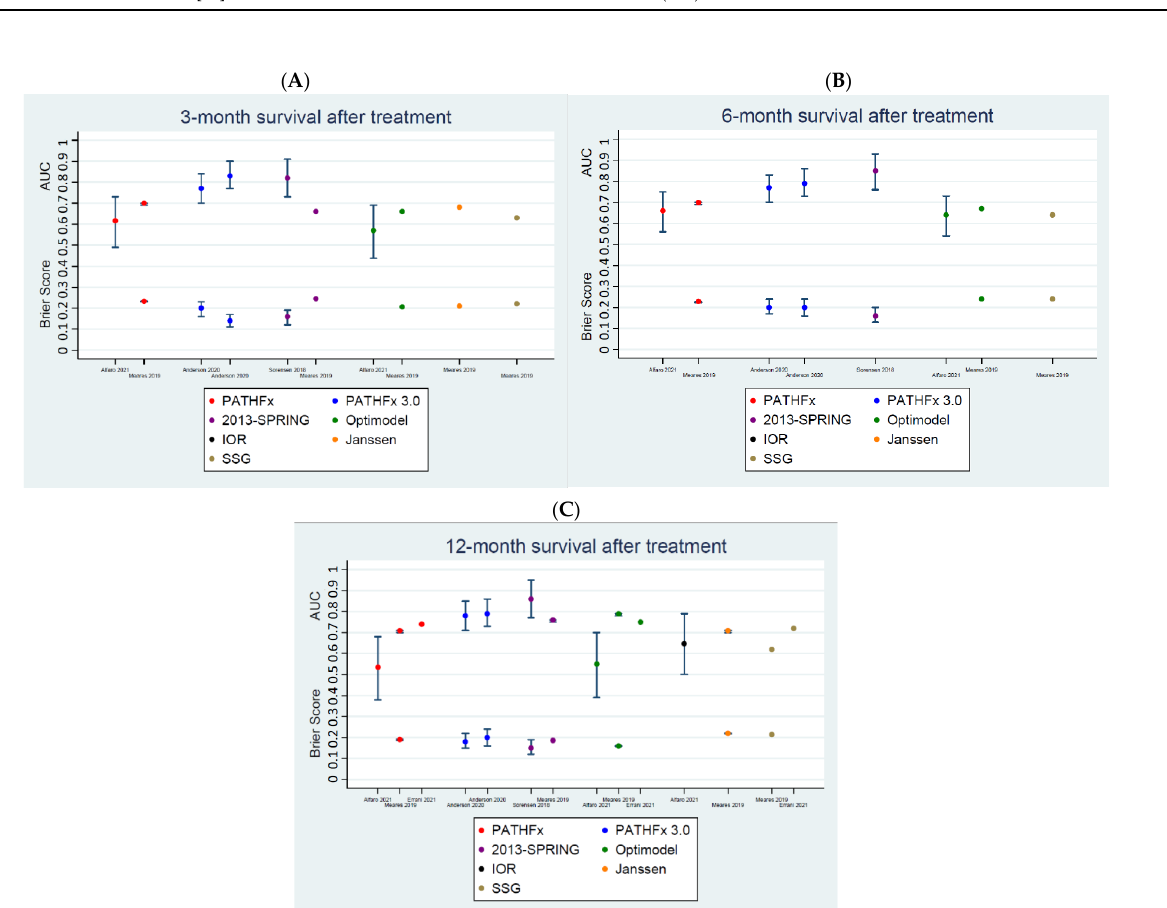
Figure 2. Performance status graphs, AUCs (area under the curve) and Brier scores. ( A ). Comparing metastatic bone disease predicting survival models for 3 months of survival across externally validated studies. ( B ). Comparing metastatic bone disease predicting survival models for 6 months of survival across externally validated studies. ( C ). Comparing metastatic bone disease predicting survival models for 12 months of survival across externally validated studies. Table 2. Summary of performance metrics of externally validated models.